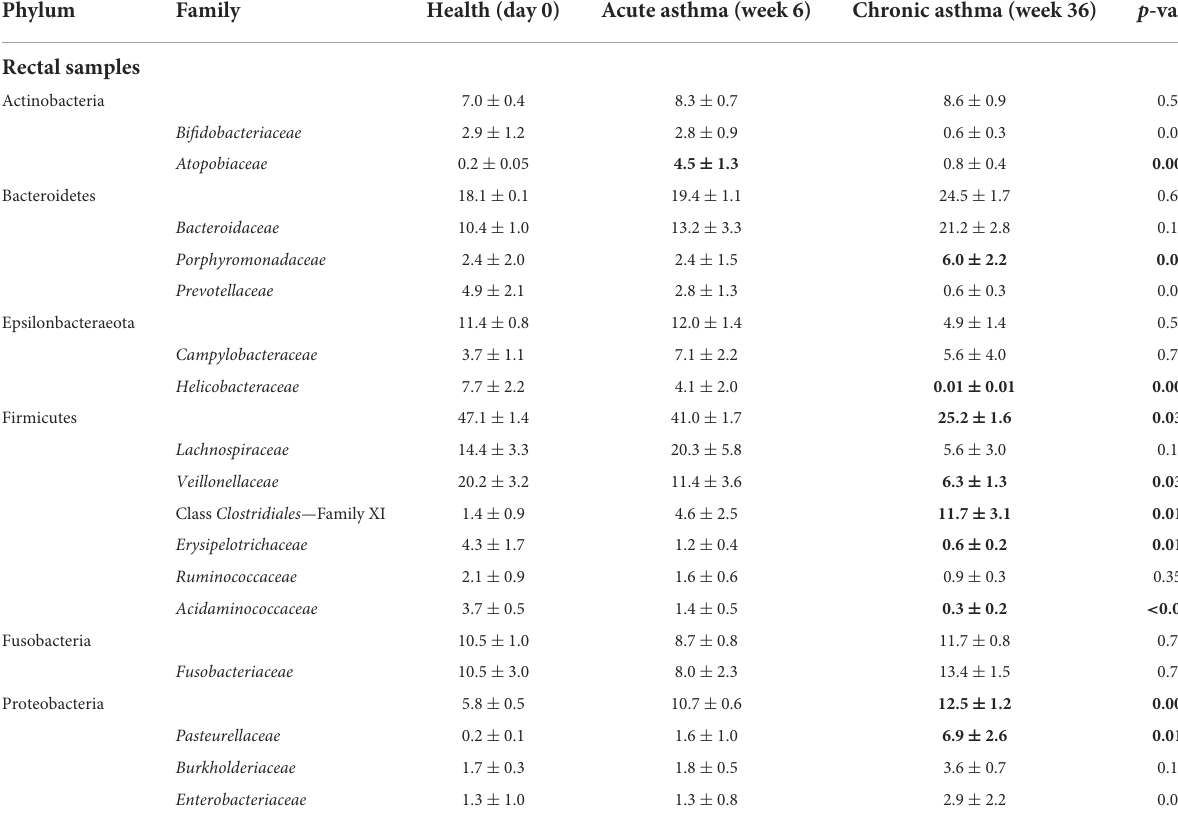
TABLE 1 Relative abundance (mean ± SEM%) of taxa at the level of family present in any rectal sample at any time point at > 0.5% accounting for > 90% of the overall microbial community. Phylum